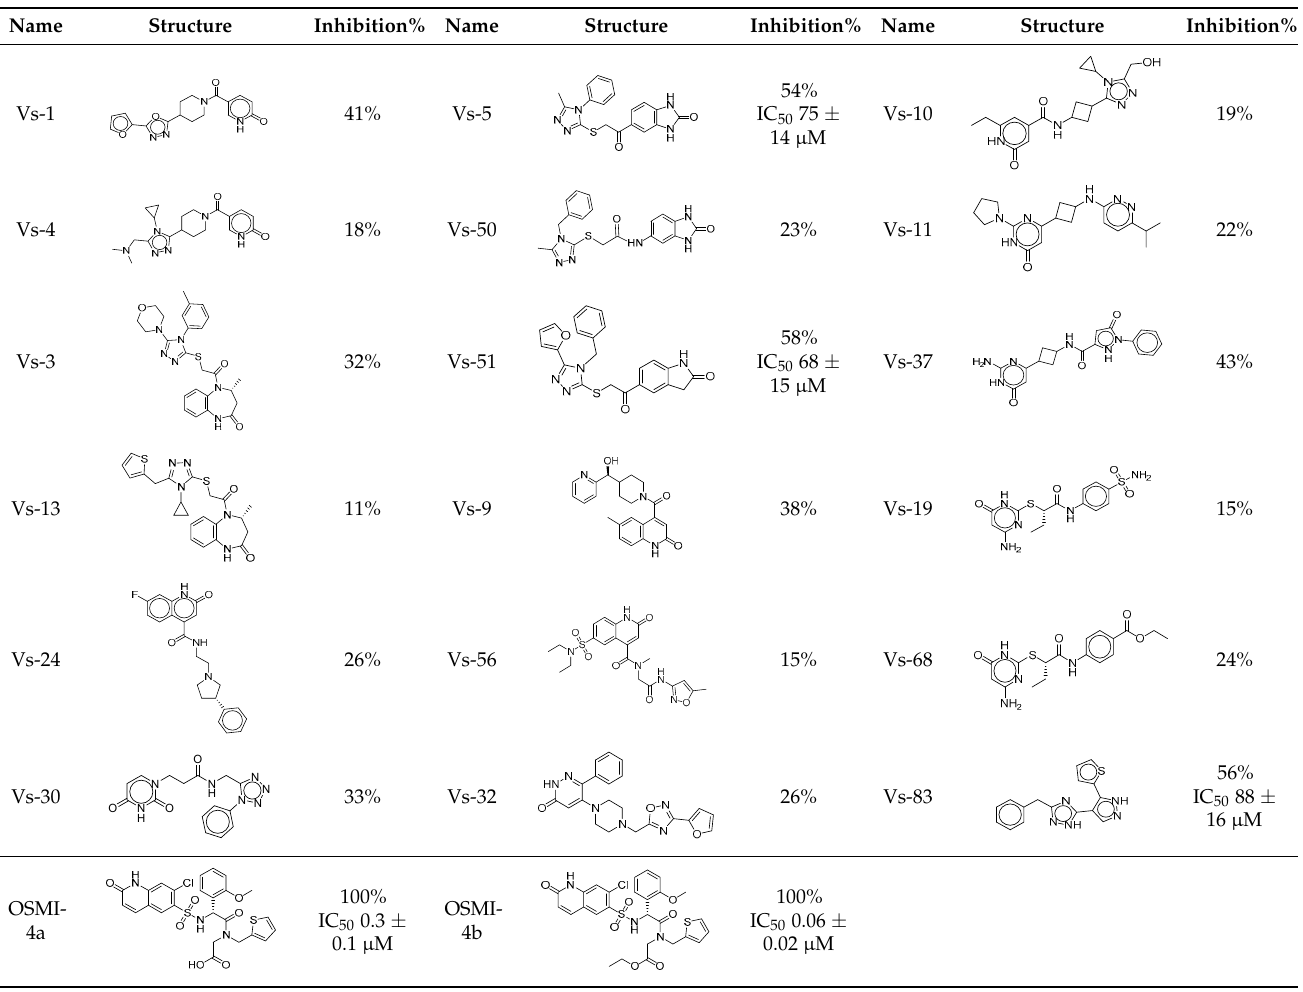
Table 1. Results of the OGT fluorescence-based transferase activity assay. The compounds were screened at a fixed concentration of 100 µM and the results are expressed as % of inhibition with reference to the DMSO control (0% inhibition). OSMI-4a and OSMI-4b were used as positive controls (100% inhibition). For the most promising hits (inhibition > 50%) Vs-5, Vs-51, and Vs-83, C 50 values were measured using the same assay in two independent experiments.